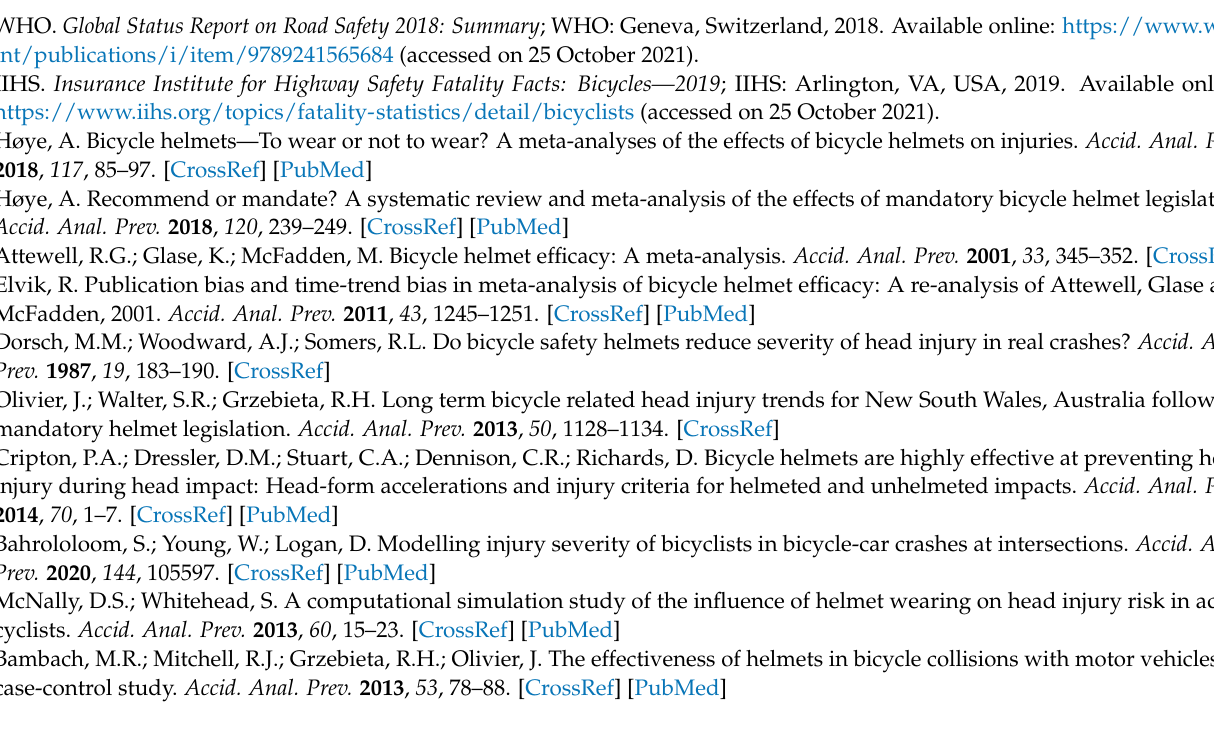
Figure A1. Dimensions of the proposed expandable helmet (before and after inflation).